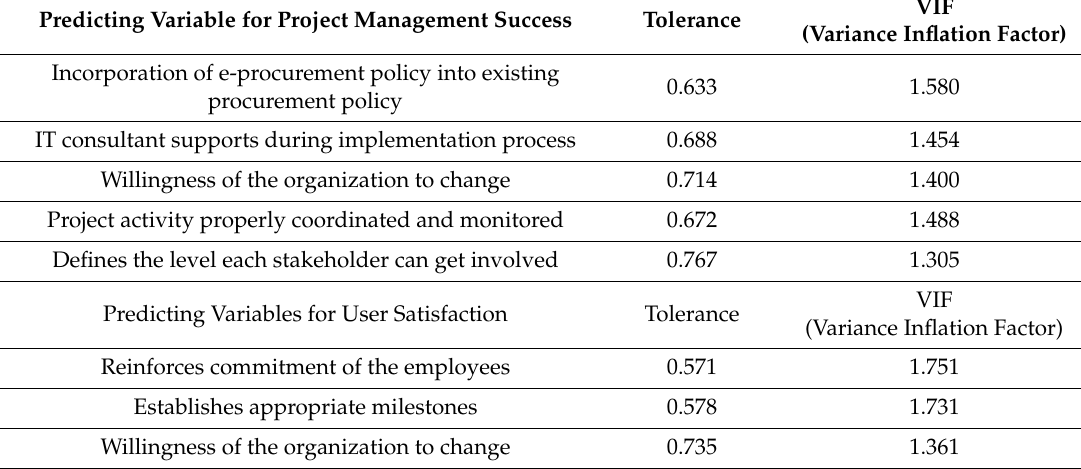
Figure 4. Histogram regression standardized residual.